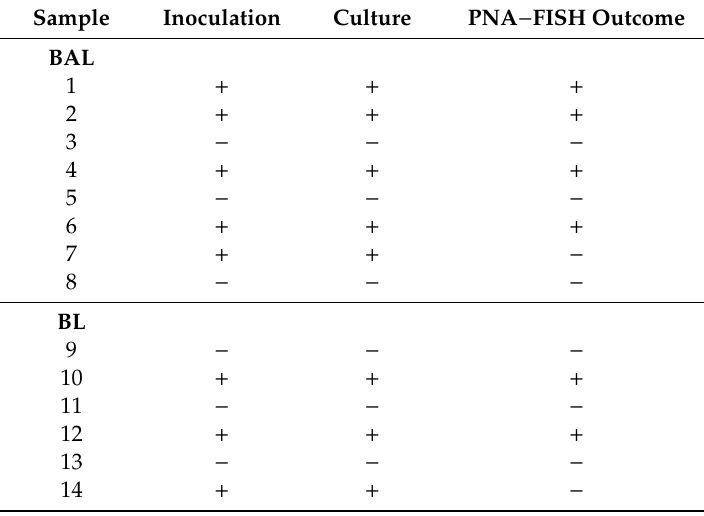
Table 4. PNA-FISH blind test results. Thirteen clinical samples were inoculated artificially with